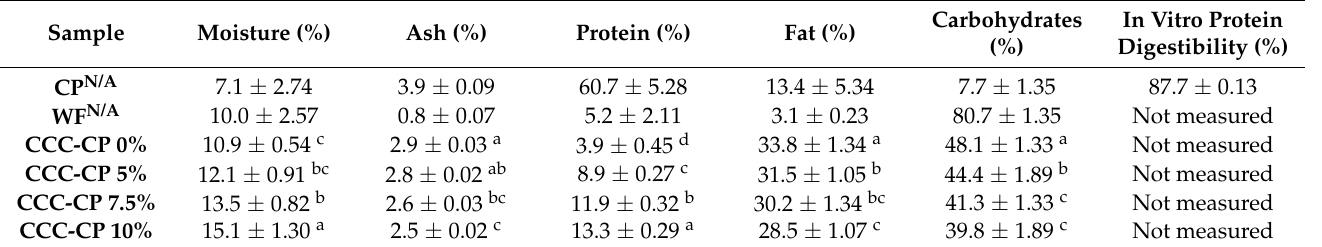
Table 1. Chemical composition of cricket powder.